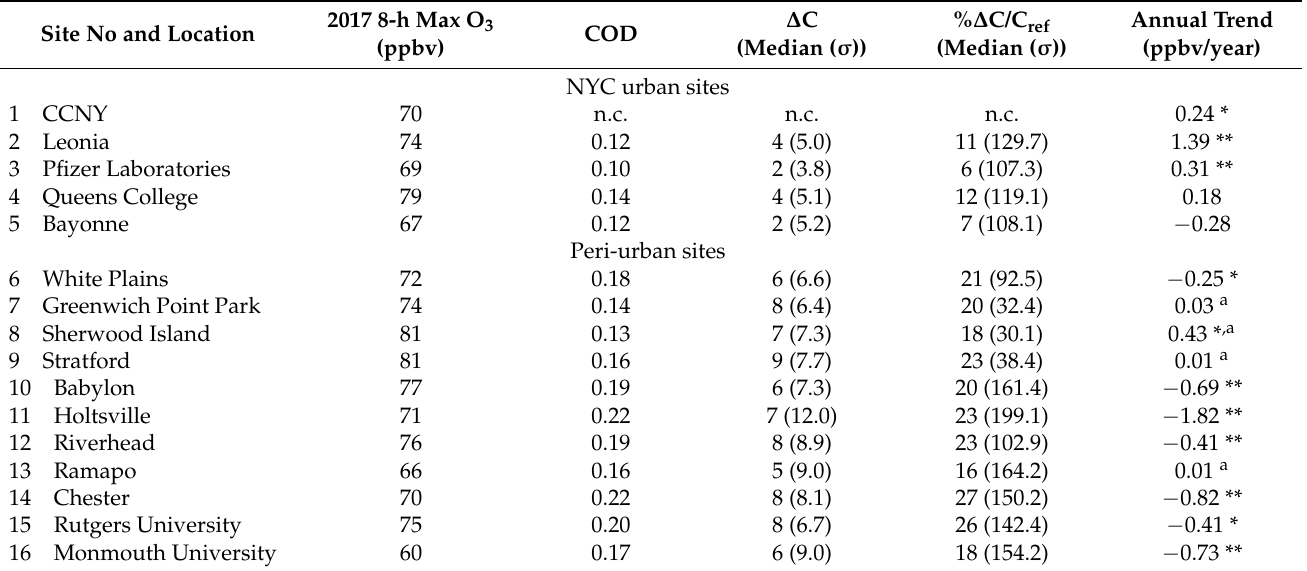
Table 2. The 2017 8-h max O 3 concentration, mean COD, median (and standard deviation ( σ )) o ϕ absolute ( ∆ C) and relative (% ∆ C/Ref) concentration differences (compared to CCNY site) and annual trends of 8-h max O 3